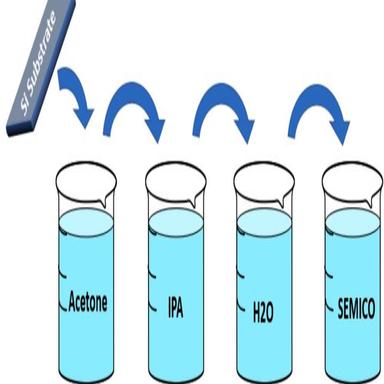
The standard degreasing process in sequential steps of different degreasers. Each step takes two minutes, starting with acetone, then IPA, H2O then ending up with tetramethylammonium hydroxide (SEMICO). Each step has been performed in an ultrasonic bath.